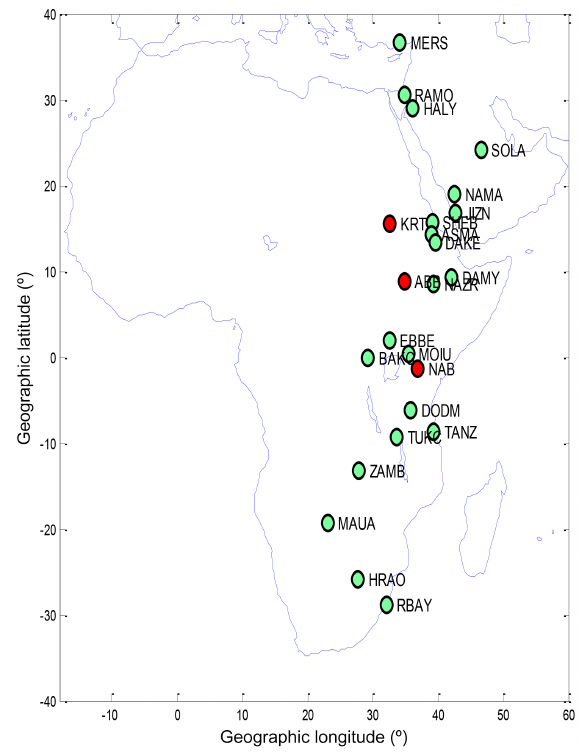
Figure 1. Map of Africa showing locations of